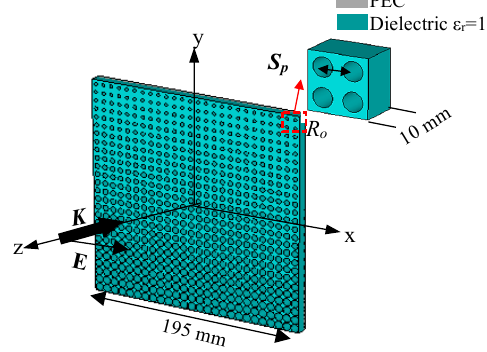
Fig. 1. The configuration of loaded metallic sheet with perforated dielectric